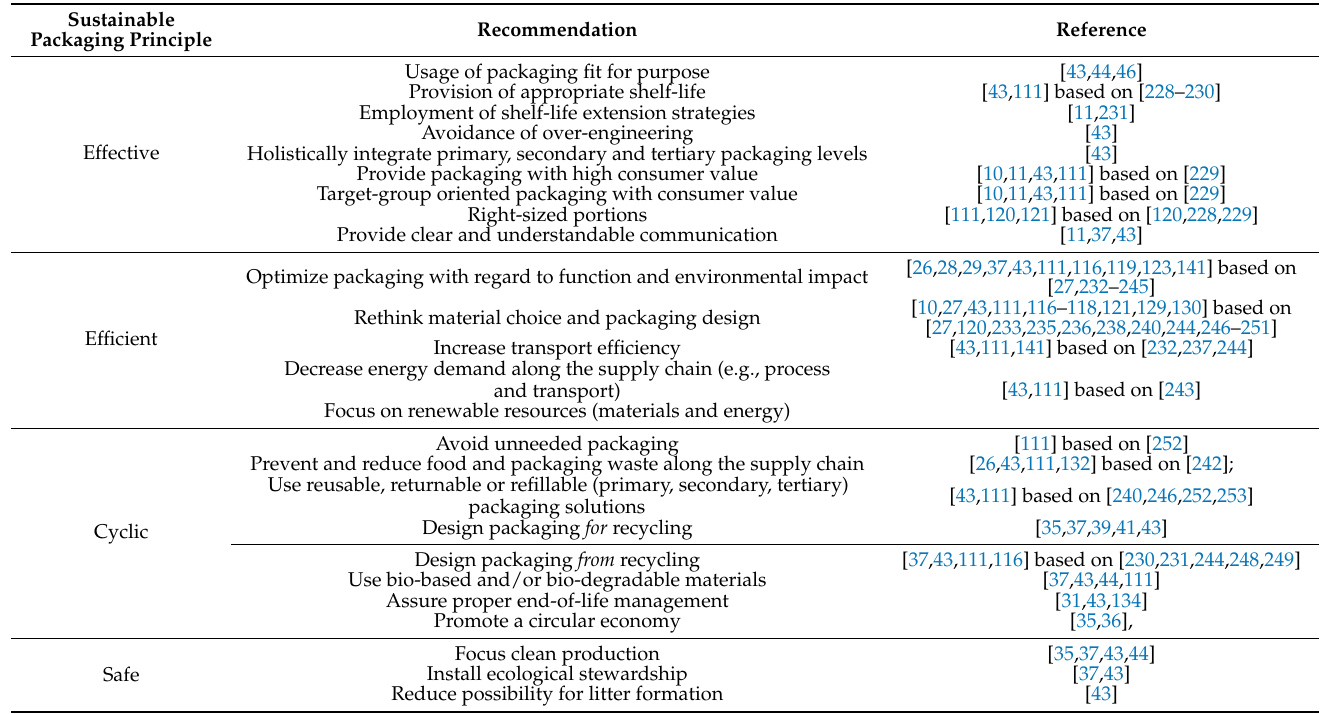
Table 3. Recommendations for improving the sustainability of food packaging based on the structure given by